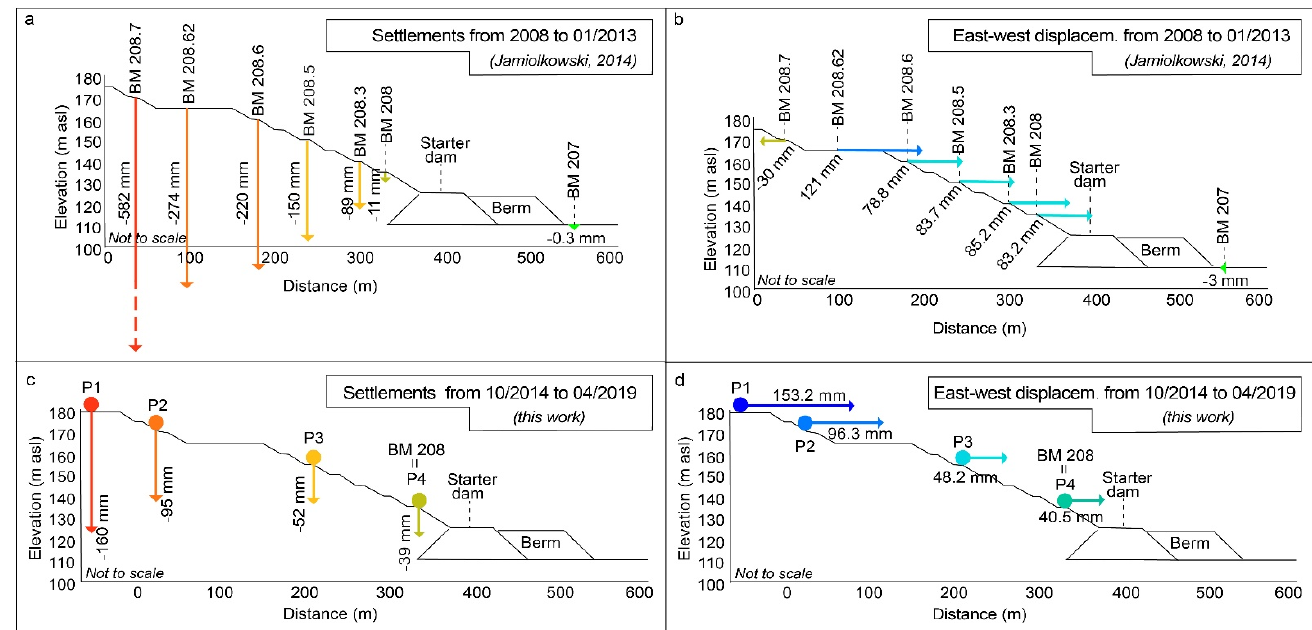
Figure 7. Schematic cross-section XVIE (location in Figure 6a,b) on the eastern dam; vectors represent the cumulative settlement (mm) at different heights of the dam body; ( a , b ) settlements and east-west displacements, respectively, from 2008 to January 2013 at 7 benchmarks (deduced from [1]); ( c , d ) settlements and east-west displacements respectively, from October 2014 to April 2019, measured by A-DInSAR, at points P1, P2, P3, and P4 (located in Figure 5).